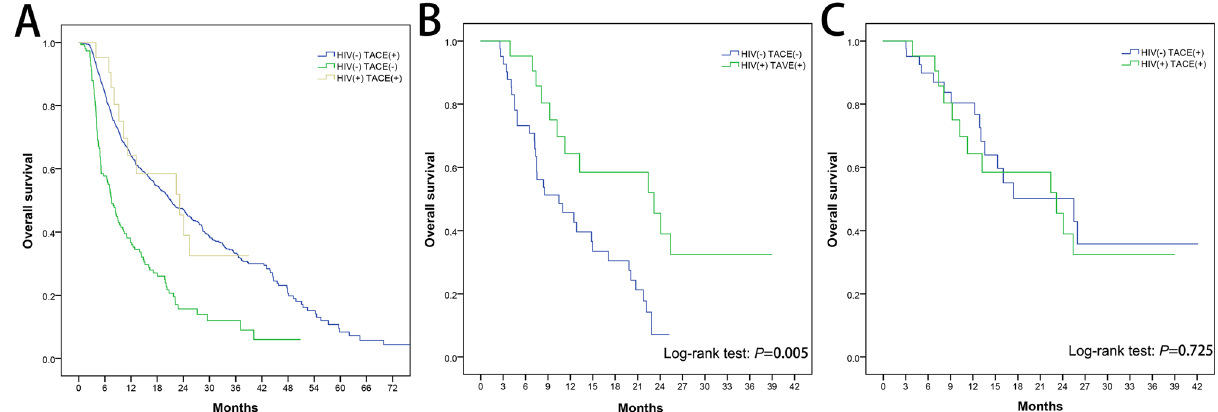
Figure 1. Kaplan Meier curve analysis of overall survival. ( A ) Overall survival rate of HIV (+) TACE (+), HIV (−) TACE (+) and HIV (−) TACE (−) groups before matching ( B ) post-matched overall survival rate of HIV (+) TACE (+) and HIV (−) TACE (−) ( C ) post-matched overall survival rate of HIV (+) TACE (+) and HIV (−) TACE